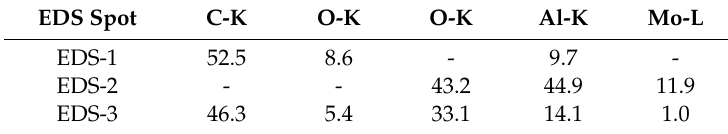
Table 4. Chemical composition in the locations identified in Figures 15 and 16,